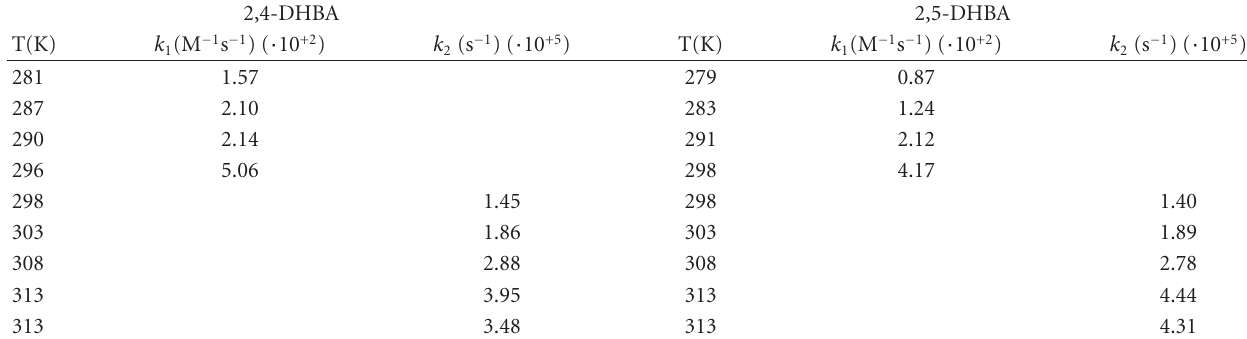
Table 1: Values of k 1 and k 2 at various